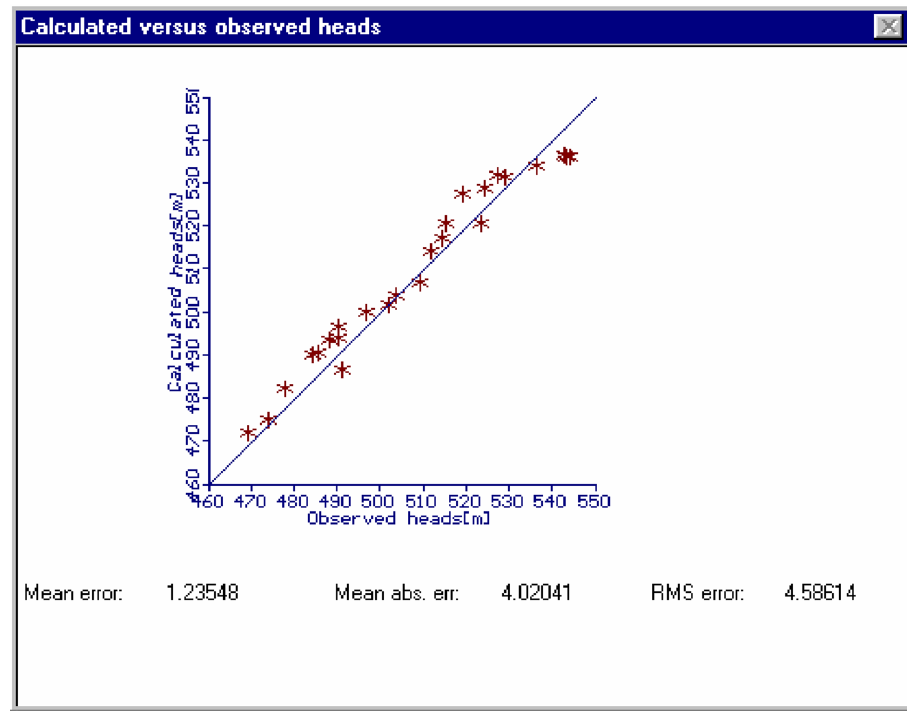
Fig. 7 Correlation of computed and observed water levels (June